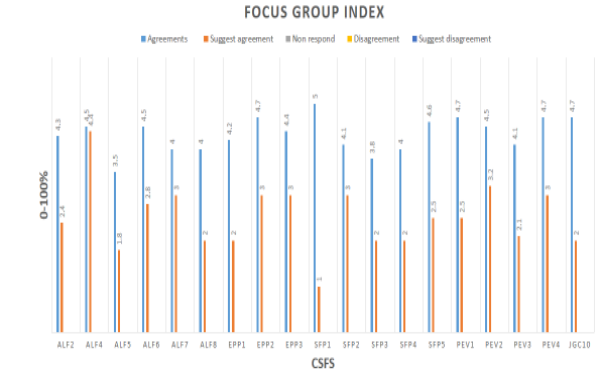
Figure 3 . Focus Group Agreement Index